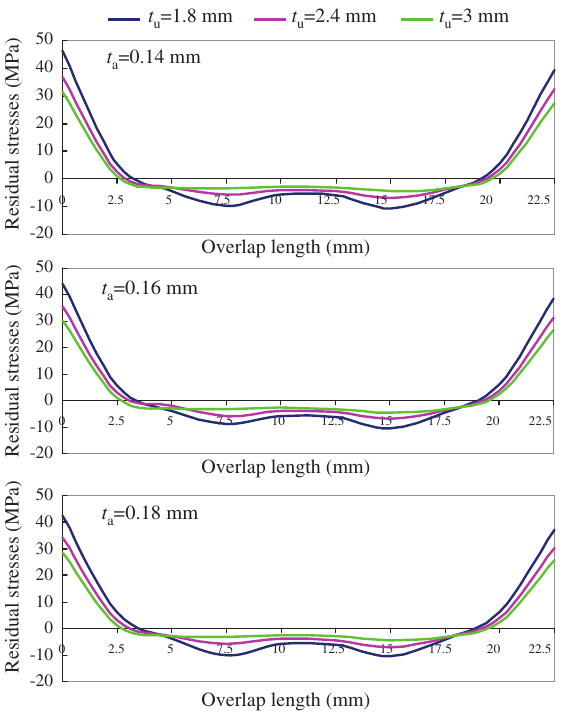
Figure 9 Effect of adherends’ thickness on the residual shear stress for adhesive length of 2 L = 20 mm with different adhesive thickness.